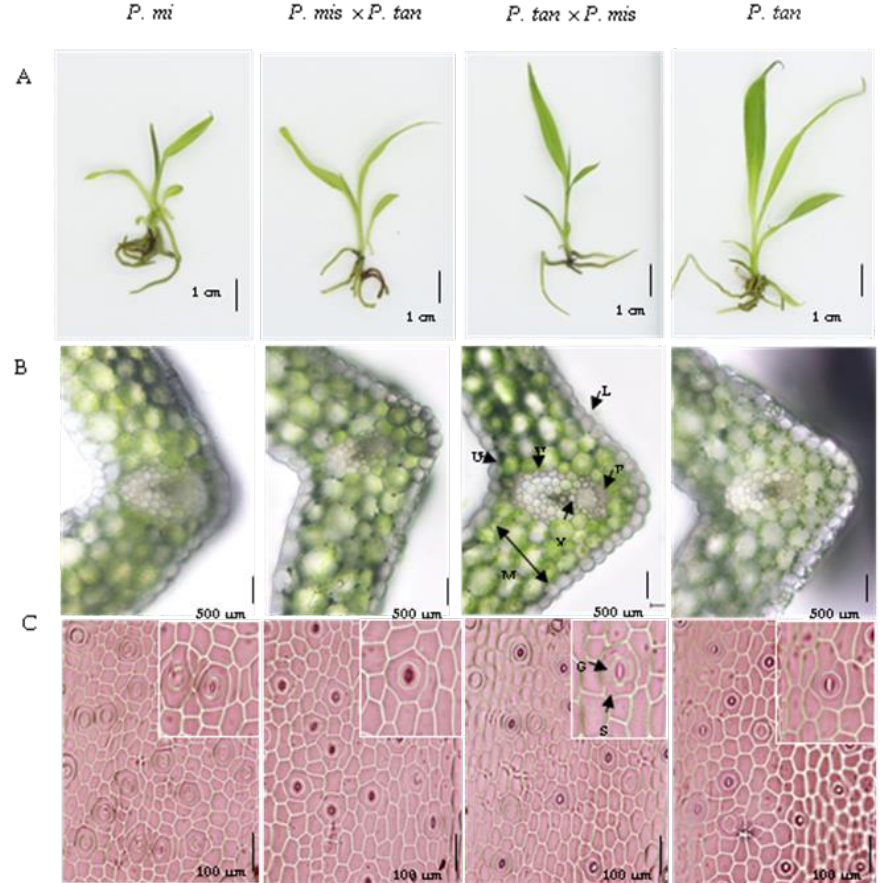
Figure 2. Characteristics of plantlet ( A ), leaf cross section ( B ) and leaf epidermis containing stomata complexes of P . mishmensis , P . tankervilliae and their F 1 interspecific hybrids ( C ): G, guard cell; L, lower epidermis; M, mesophyll; P, phloem; S, subsidiary cell; U, upper epidermis; X, xylem.